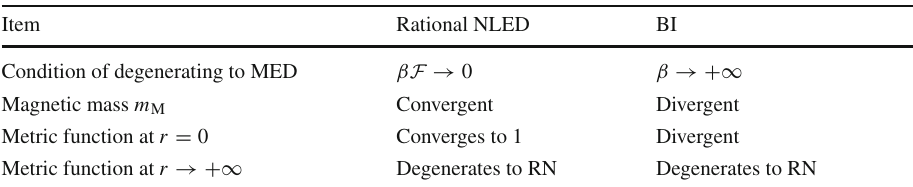
Table 5 Summary of the Item Rational NLED BI comparisons between a regular magnetic BH in rational NLED Condition of degenerating to MED β F → 0 β → +∞ and a magnetically charged BI Magnetic mass m M Convergent Divergent BH Metric function at r = 0 Converges to 1 Divergent Metric function at r → +∞ Degenerates to RN Degenerates to